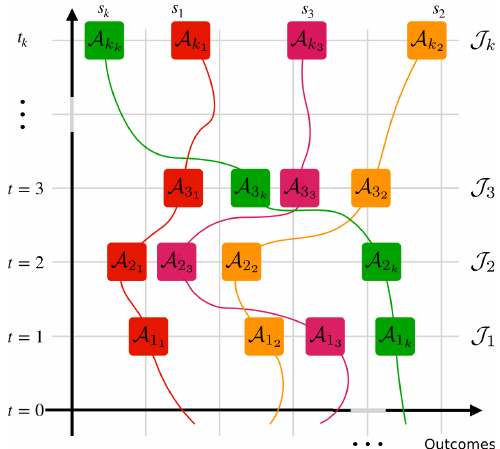
FIG. 25. “Trajectories” of a quantum stochastic process. An open quantum process is fully described once all joint proba- bilities for sequences of outcomes are known for all possible instruments an experimenter can employ to probe the process. Like in the classical case, each sequence of outcomes can be considered a trajectory, but unlike in the classical case, there is no ontology attached to such trajectories. Additionally, each sequence of outcomes in the quantum case corresponds to a sequence of measurement operators, not just labels. If both the process and the allowed (noninvasive) measurements are diago- nal in the same fixed basis, then the above figure coincides with Fig. 5, where trajectories of classical stochastic processes are considered. Importantly, while in classical physics, only proba- bilistic mixtures of different trajectories are possible, quantum mechanics allows for the coherent superposition of “trajectories”